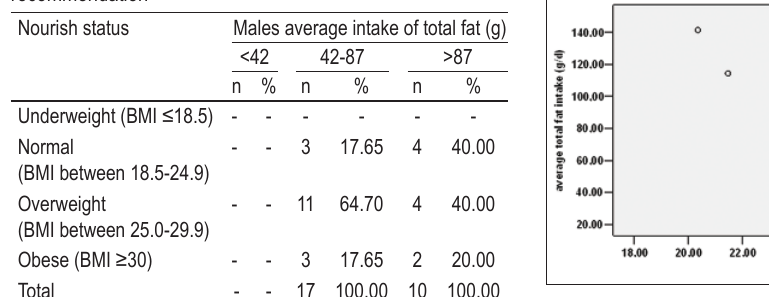
TABLE 5. Average total fat intake of males compared with recommendation